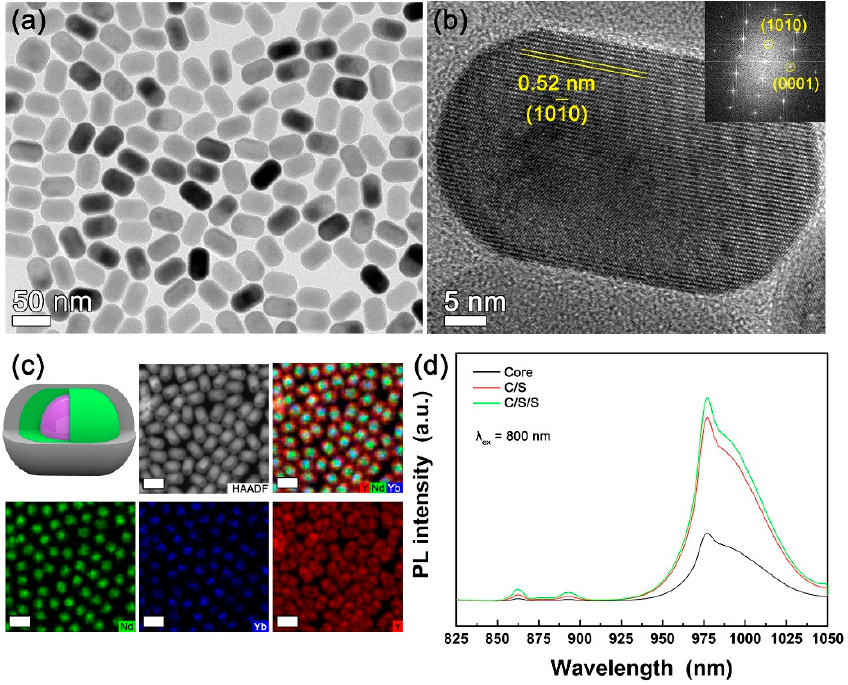
Figure 5. ( a ) TEM image and ( b ) HR-TEM image of NaYF 4 :Nd (30%),Yb (10%)/NaYF 4 :Nd (10%)/NaYF 4 C/S/S DSNPs. The inset of ( b ) is an FFT pattern for the HR-TEM image shown in ( b ). ( c ) Schematic illustration showing the C/S/S-structured DSNP, HAADF-STEM image, and EDS map images (merged image, Nd L α (green), Yb L α (blue), and Y K α (red) maps) of NaYF 4 :Nd (30%),Yb (10%)/NaYF 4 :Nd (10%)/NaYF 4 C/S/S DSNPs. Scale bars in the ( c ) indicate 50 nm. ( d ) PL spectra of NaYF 4 :Nd (30%),Yb (10%) core, NaYF 4 :Nd (30%), Yb (10%)/NaYF 4 :Nd(10%) C/S, and NaYF 4 :Nd